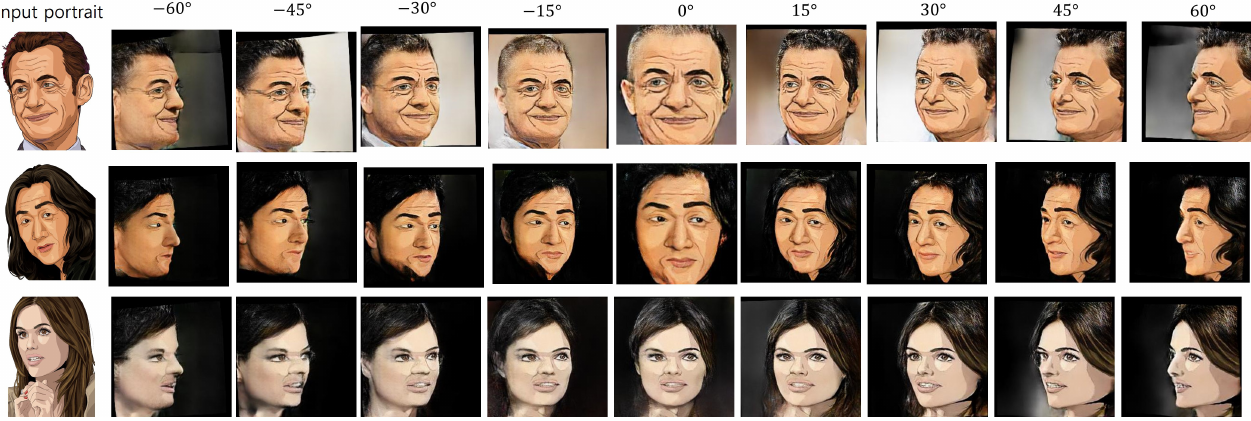
Figure 11. Rotation of